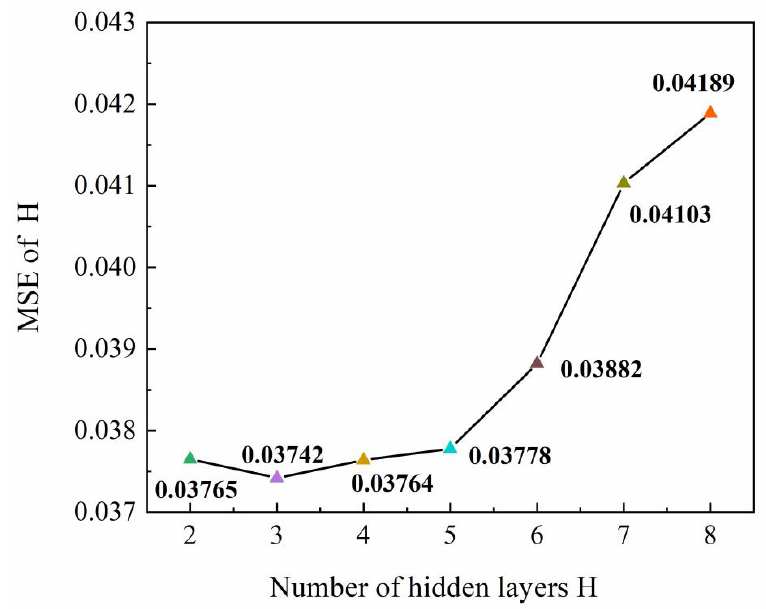
Figure 10. The influence of the number of network layer on prediction accuracy.